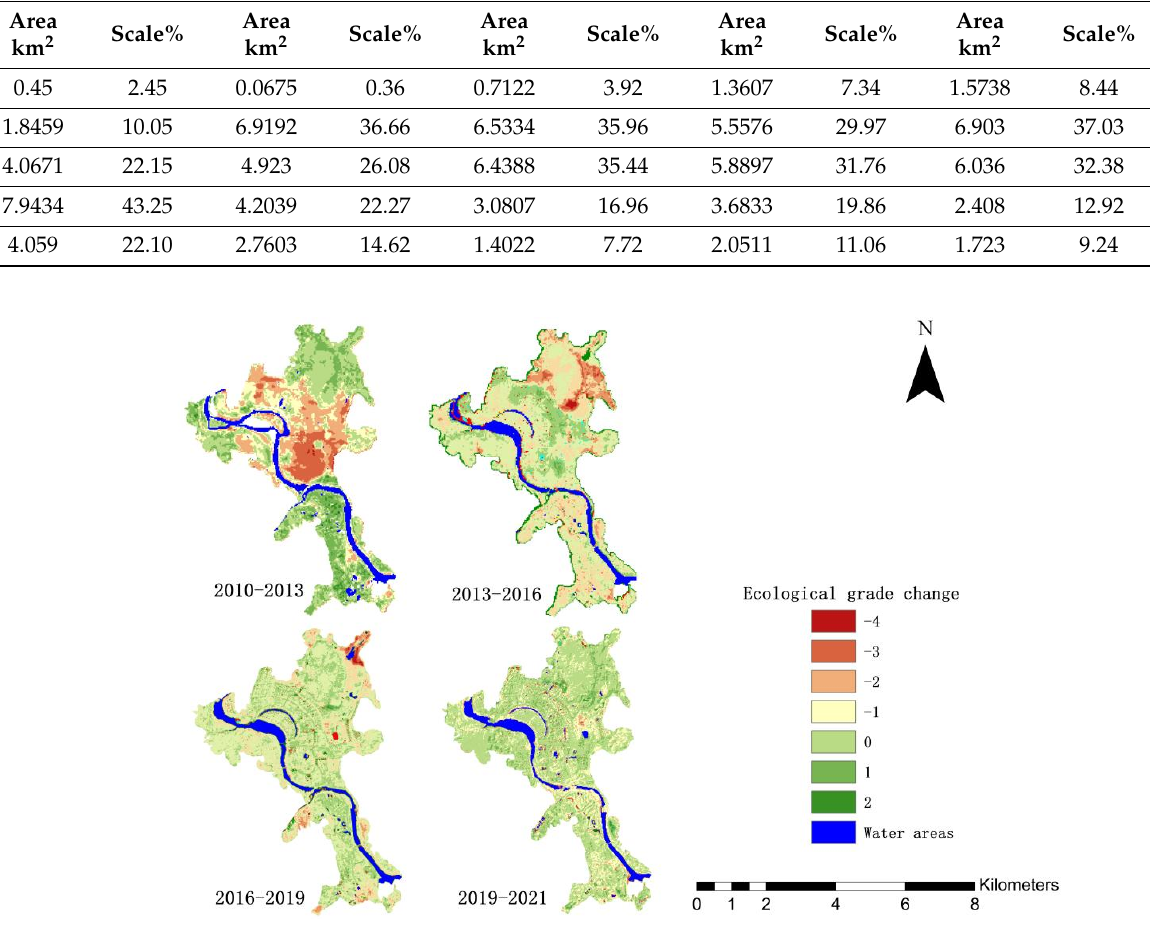
Figure 9. Ecological class distribution and change. Table 6. RSEI level analysis statistics.